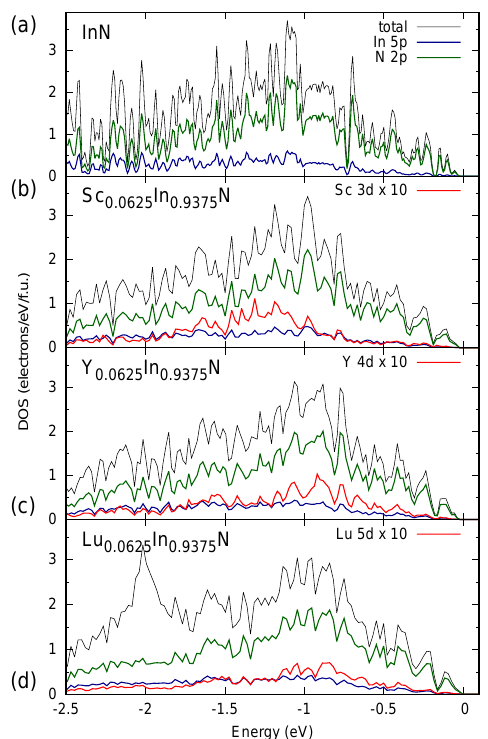
Figure 4. The total and partial density of states (DOS) contributions calculated (MBJGGA) for wurtzite ( a ) InN, ( b ) Sc 0.0625 In 0.9375 N, ( c ) Y 0.0625 In 0.9375 N, and ( d ) Lu 0.0625 In 0.9375 N. Please note that the d -type contributions of RE ions are magnified by